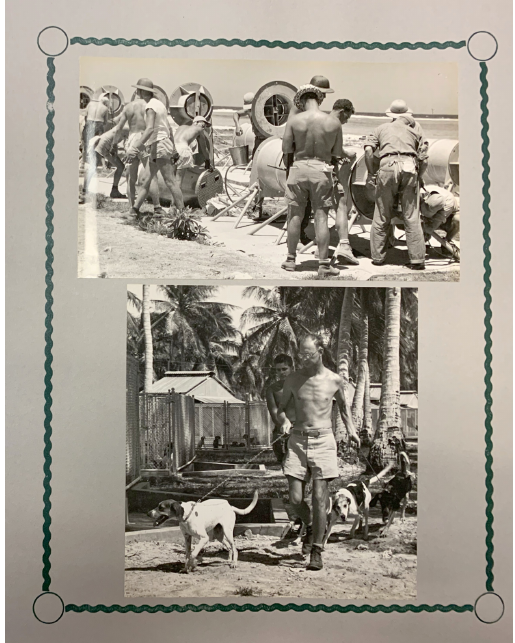
Figure 7: On the album’s next page, workers load dogs into “exposure containers” ( top ) and bring new dogs from the temporary island kennel ( bottom ). Image courtesy of the Rare Book & Manuscript Library, University of Illinois at Urbana-Champaign.